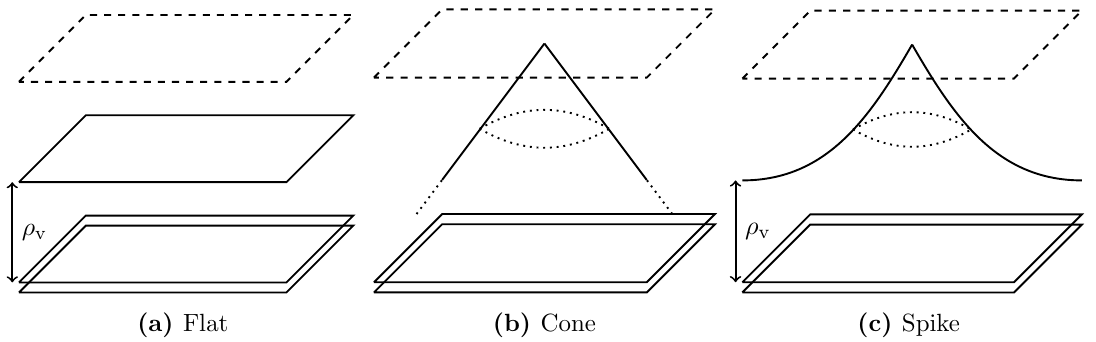
Figure 1. Cartoons of the probe D3-brane solutions we study in this paper. The parallelograms at the bottom represent the stack of D3-branes generating the background AdS 5 (cid:2) S 5 , and the dashed parallelogram at the top represents the AdS 5 boundary. The shapes in between represent the probe D3-brane solutions describing (a) the N = 4 Coulomb branch, where the D3-brane’s position (cid:26) v maps to an adjoint scalar’s VEV, (b) a symmetric-representation 1/2-BPS Wilson line, and (c) such a Wilson line screened by the Coulomb branch’s scalar VEV. We call these the \(cid:13)at," \cone," and \spike" D3-brane solutions,